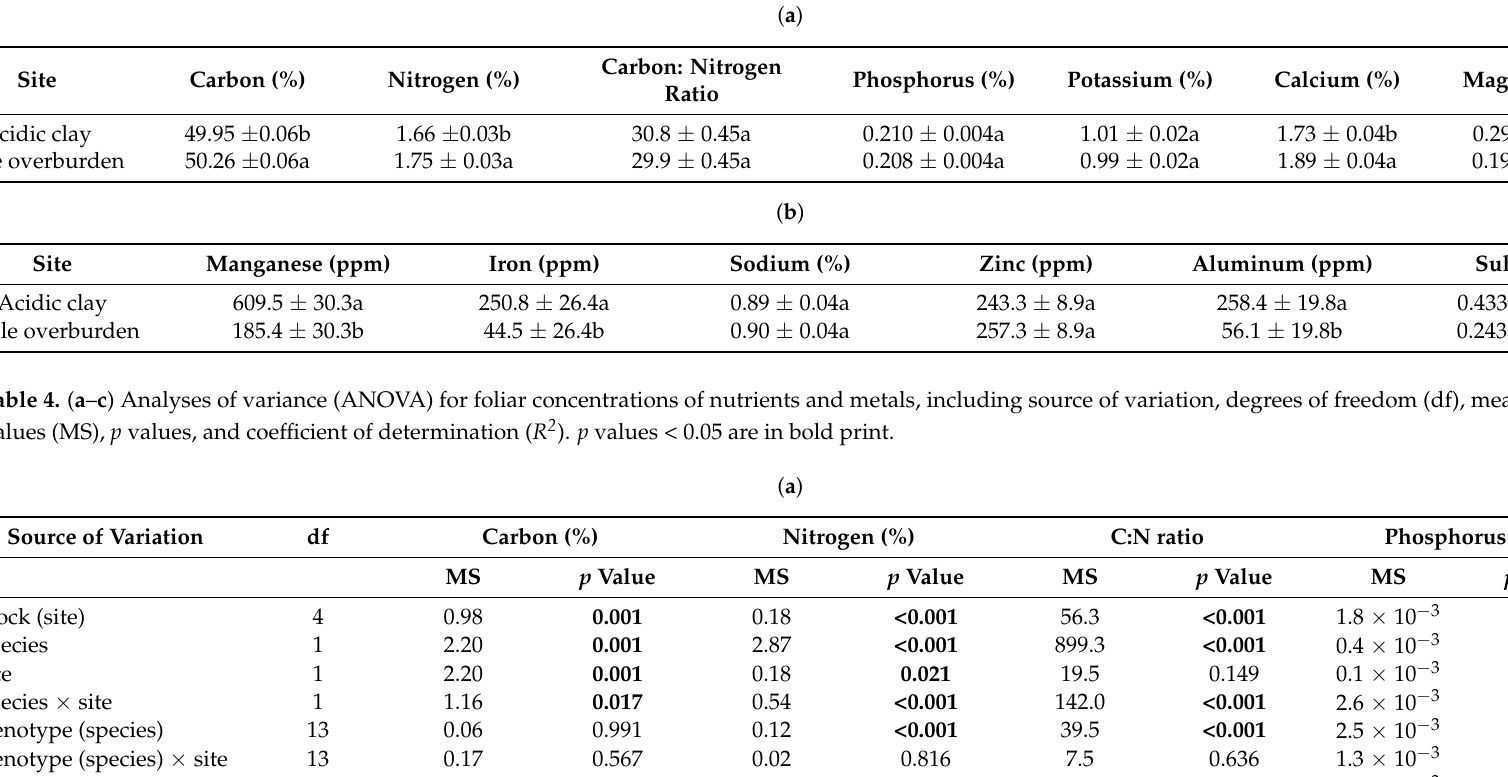
Table 3. ( a , b ) Foliage concentrations of nutrients and metals (Mean ± SE) from two sites, an acidic clay deposit and a shale rock overburden, at the Salmon Harbour mine site. Sites with different letters are significantly different at p = 0.05.